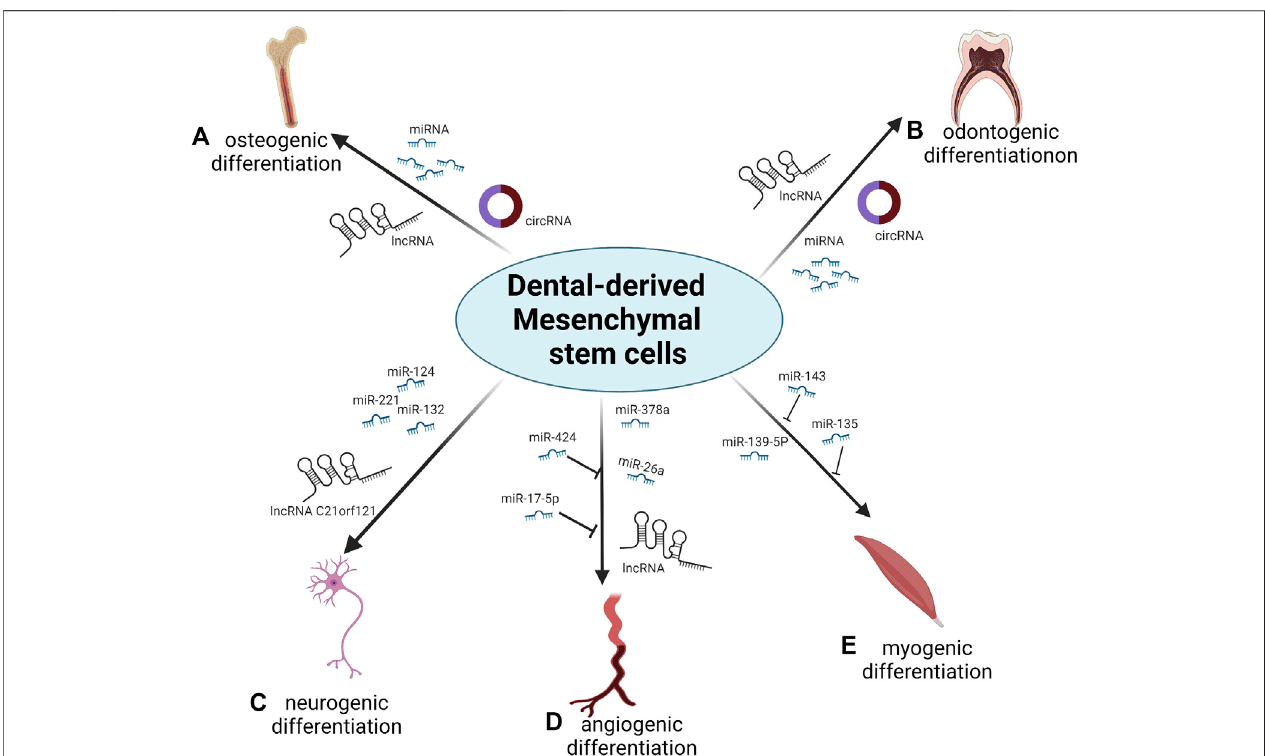
FIGURE1| OverviewoftheroleofncRNAsduringdifferentiation ofDMSCs. (A) NumerousmiRNAs,lncRNAsandcircRNAs regulate theosteogenicdifferentiation of DMSCs. (B) Numerous miRNAs, lncRNAs and circRNAs regulate the odontogenic differentiation ofDMSCs. (C) miR-132, miR-124, miR-221and lncRNA C21orf121 promote the neurogenic differentiation of DMSCs. (D) miR-378a and miR-26a promote the angiogenic differentiation of DMSCs; miR-424 and miR-17-5p inhibit the angiogenic differentiation of DMSCs; numerous lncRNAs regulate the angiogenic differentiation of DMSCs. (E) miR-139-5p promotes the myogenic differentiation of DMSCs; miR-143 and miR-135 inhibit the myogenic differentiation of